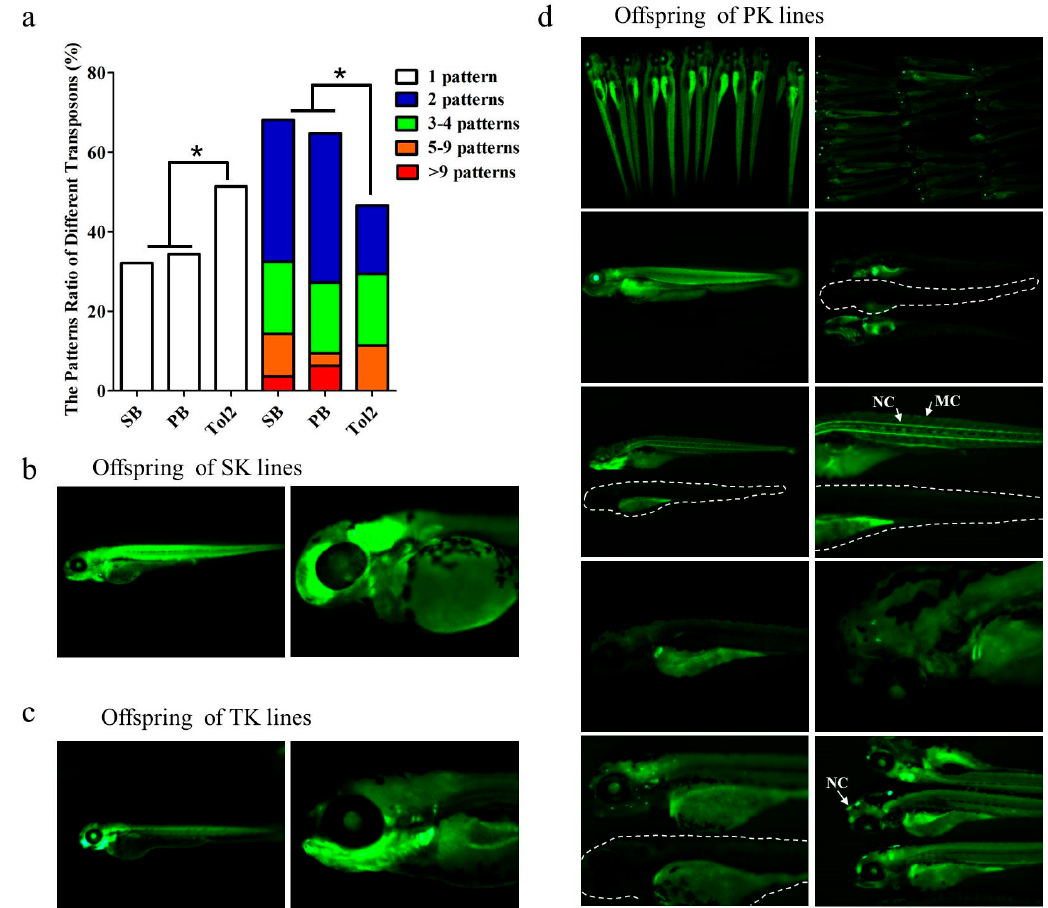
Figure 2. ET pattern difference based on SB , PB and Tol2 transposons in zebrafish. ( a ) Pattern difference was measured by counting the different patterns of offspring at five days postfertilization (dpf) from each single founder. Significant difference was detected using a χ -squared test; asterisk indicates p < 0.05; ( b – d ) Offspring patterns of lines generated by SK (ET lines generated by the SB transposon), TK (ET lines generated by the Tol2 transposon), and PK (ET lines generated by the PB transposon). In various expression patterns, specific expression in tissues such as eyes, kidney tubes, muscles, and swim bladders could be detected, as well as specific expression patterns in various cells such as nerve cells (NC) and muscle cells (MC). White dotted lines in ( d ) indicate the WT fish.